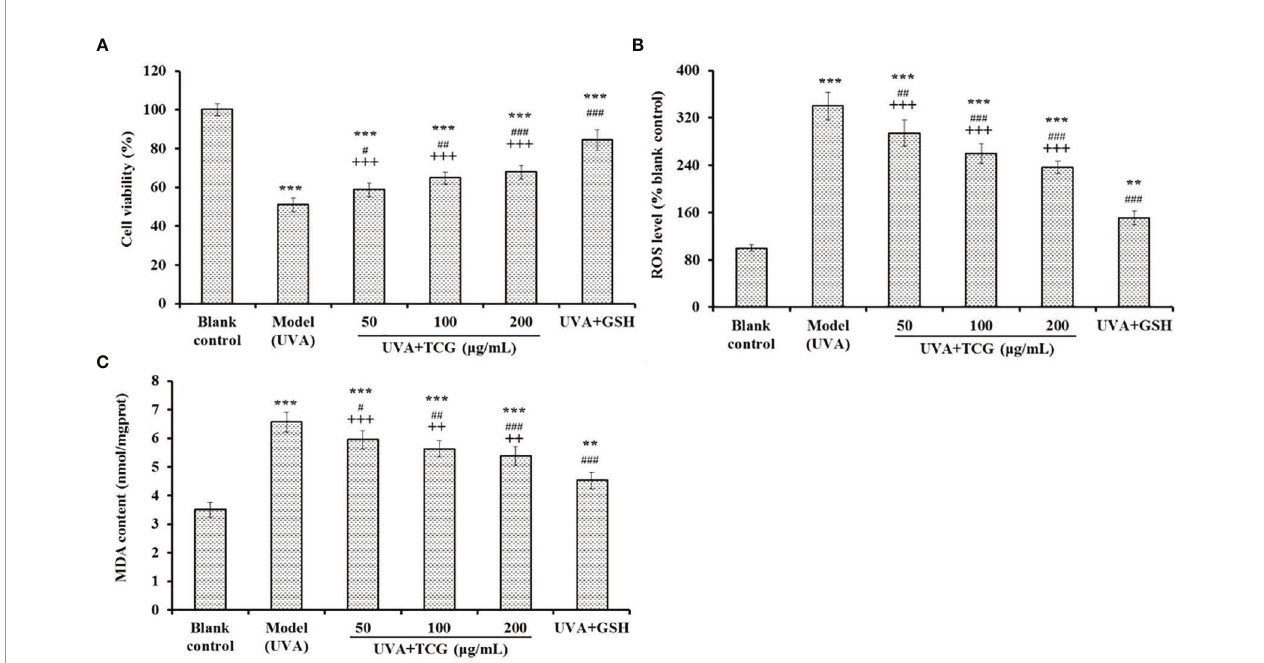
FIGURE 7 | Effects of cartilage gelatin on cell viability (A) , reactive oxygen species level (B) , and malondialdehyde content (C) of UVA-injured human skin fi broblast model. Glutathione was used as the positive control. All data are presented as mean ± SD ( n = 3). *** P < 0.001 and ** P < 0.01 vs. blank group; ### P < 0.001, ## P < 0.01, and # P < 0.05 vs. model group; +++ P < 0.001 and ++ P < 0.01 vs. UVA + GSH